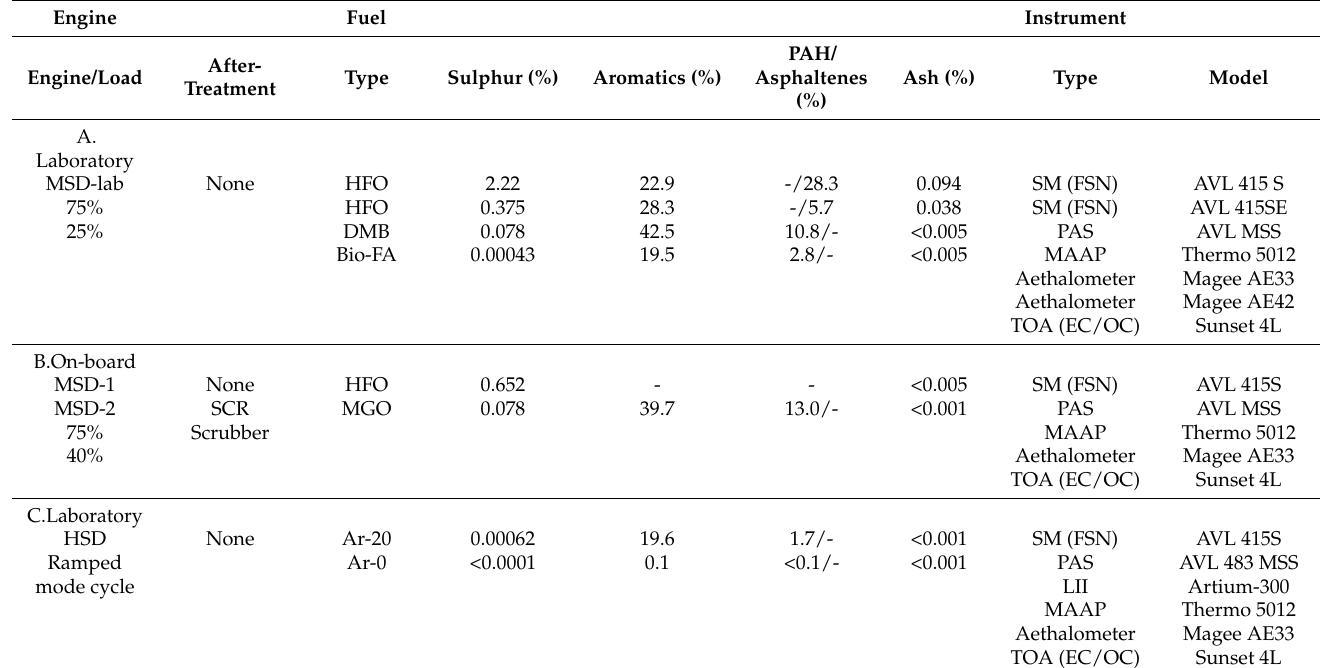
Table 1. The utilised fuels, after-treatment, measurement points, and instruments in the three measurement